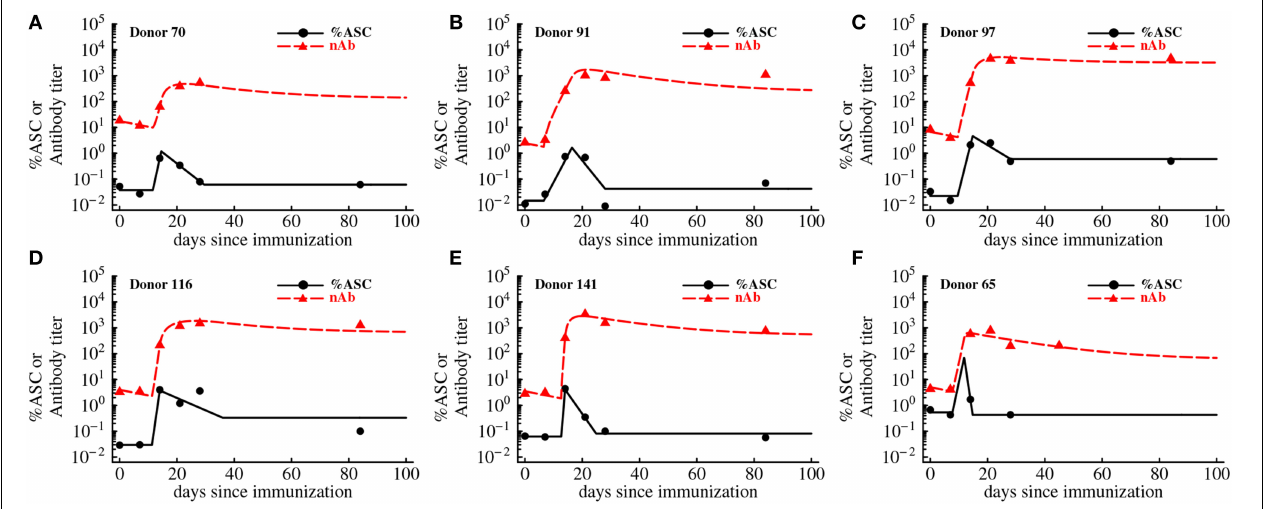
FIGURE 5 | Kinetics of VV-specific antibodies are predicted well by the accumulation and loss of antibody-secreting cells in the blood. We fit the basic mathematical model (Equations 5–6, see Materials and Methods for more detail) to the experimental data using non-linear least squares. Data are shown as markers (points